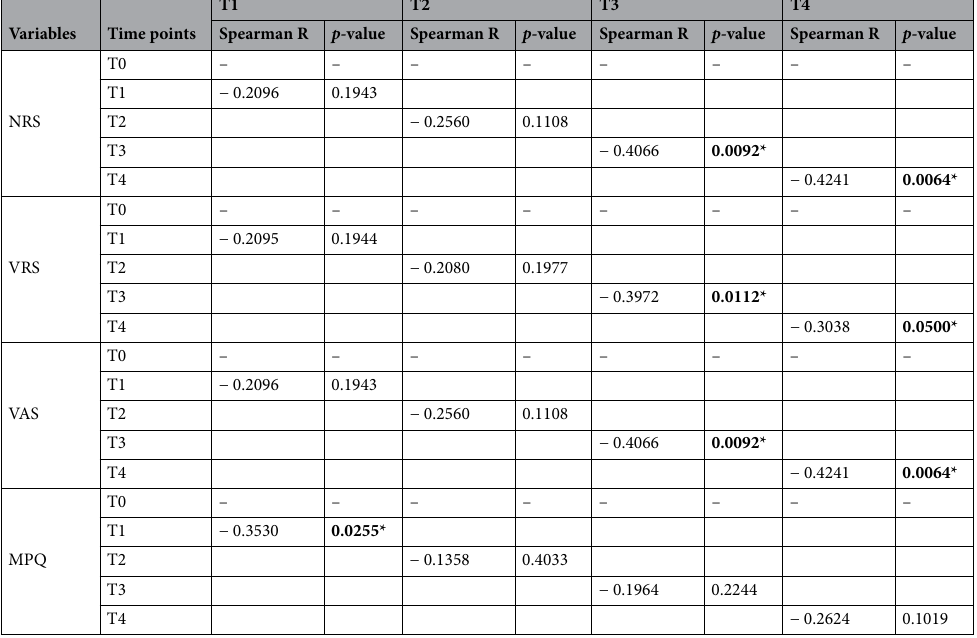
Table 4. Correlation between Brain Derived Neurotrophic Factor (BDNF) with NRS, VRS, VAS and MPQ scores by Spearman’s rank correlation. Significant values are in [bold]. * p < 0.05.